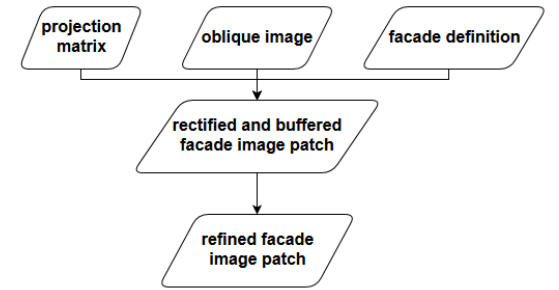
Figure 4 Flowchart regarding the facade extraction from the oblique